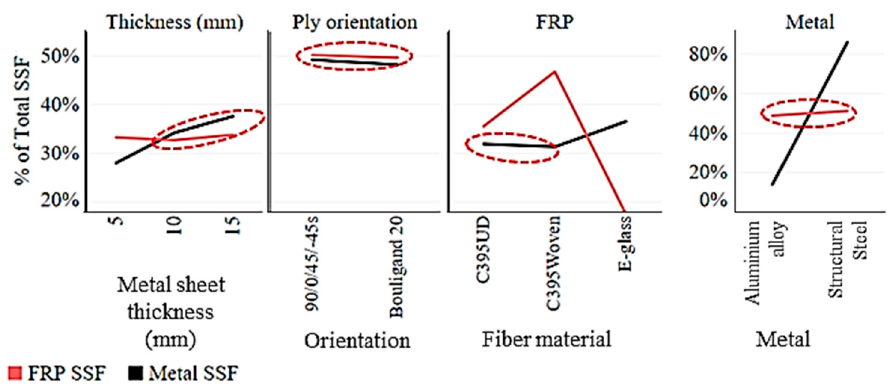
Figure 12. Parametric trends of significant factors for the Metal–FRP composite. Red ellipses indicate insignificant parametric variations.